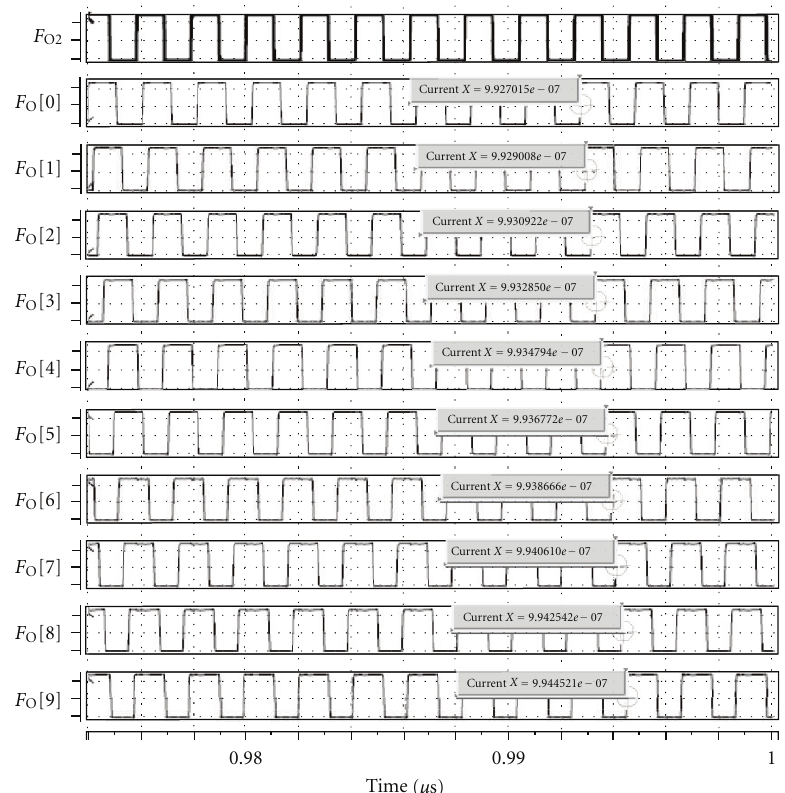
Figure 30: Postlayout simulation result of VCDL output signals from DLL3 settling operation. The simulation condition is tt/1.2V/25 ◦ C.